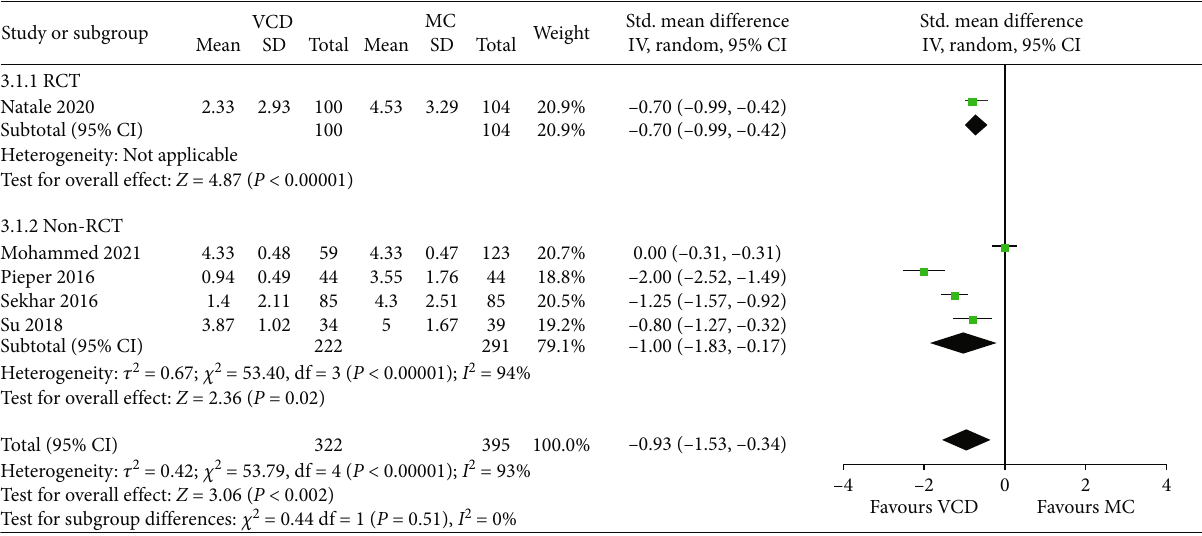
Figure 6: Forest plots comparing the patient-reported outcomes between the VCD group and MC